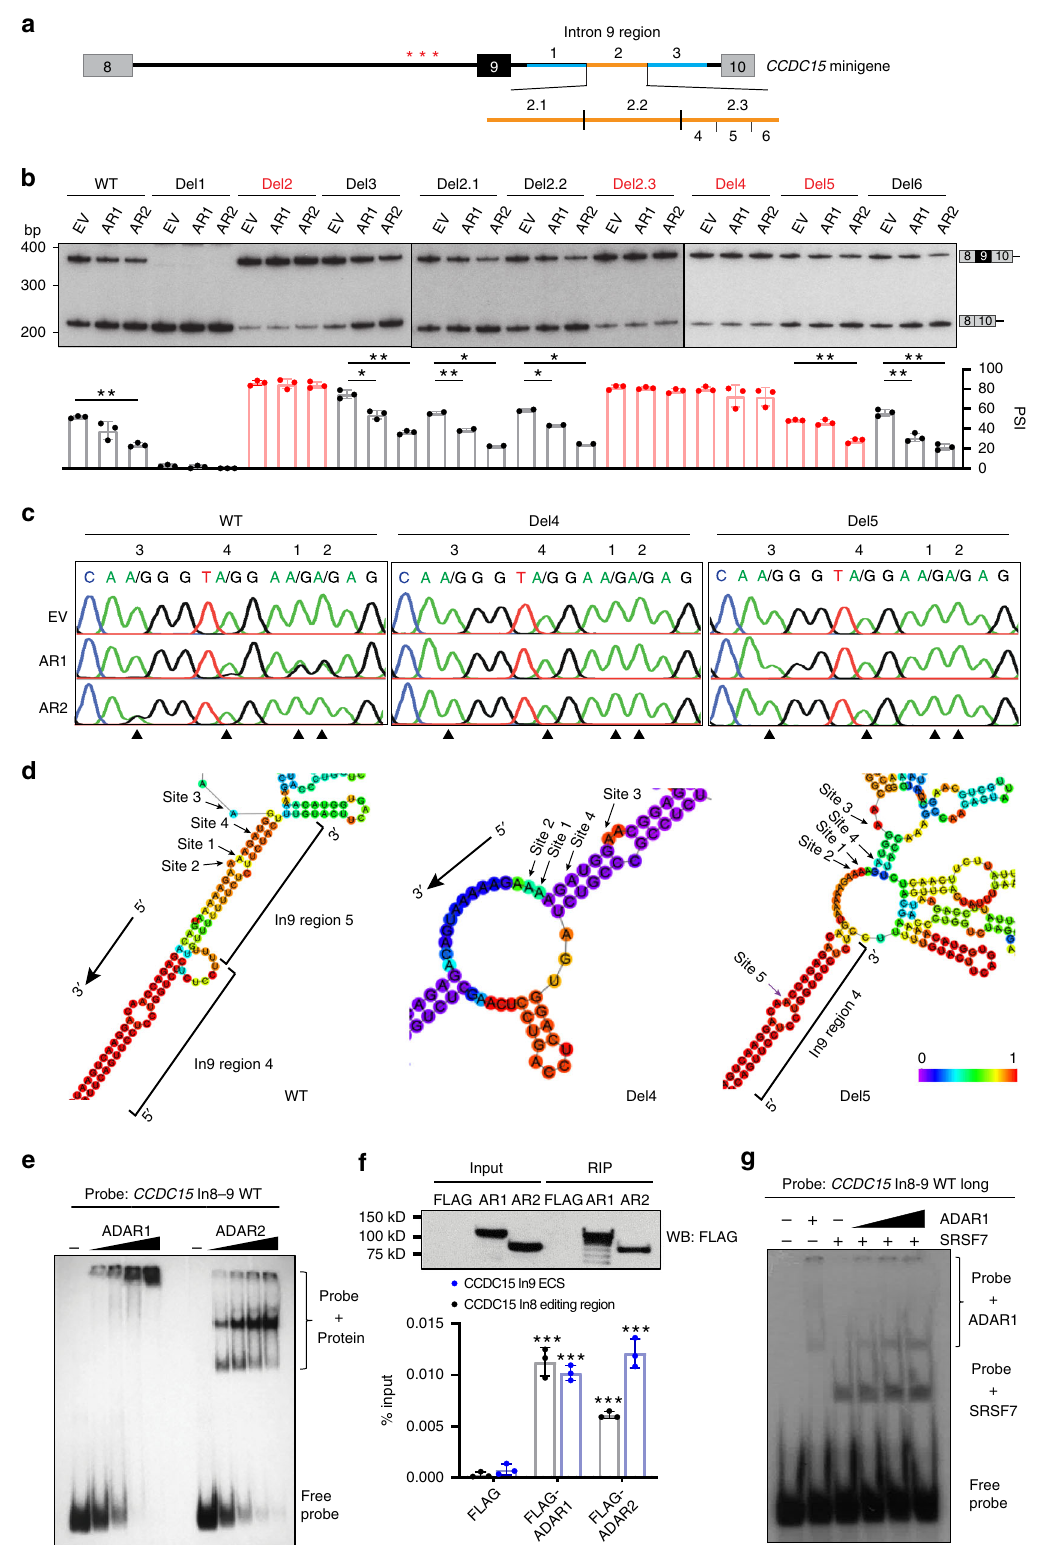
(REMSA) was carried out using an RNA probe that simulates CCDC15 intronic dsRNA (Supplementary Fig. 3e; left). In the presence of recombinant ADAR1/2 protein, a dose-dependent band shift of protein – dsRNA complex was detected (Fig. 4e), and this band shift was attenuated by a mutant probe that forms an